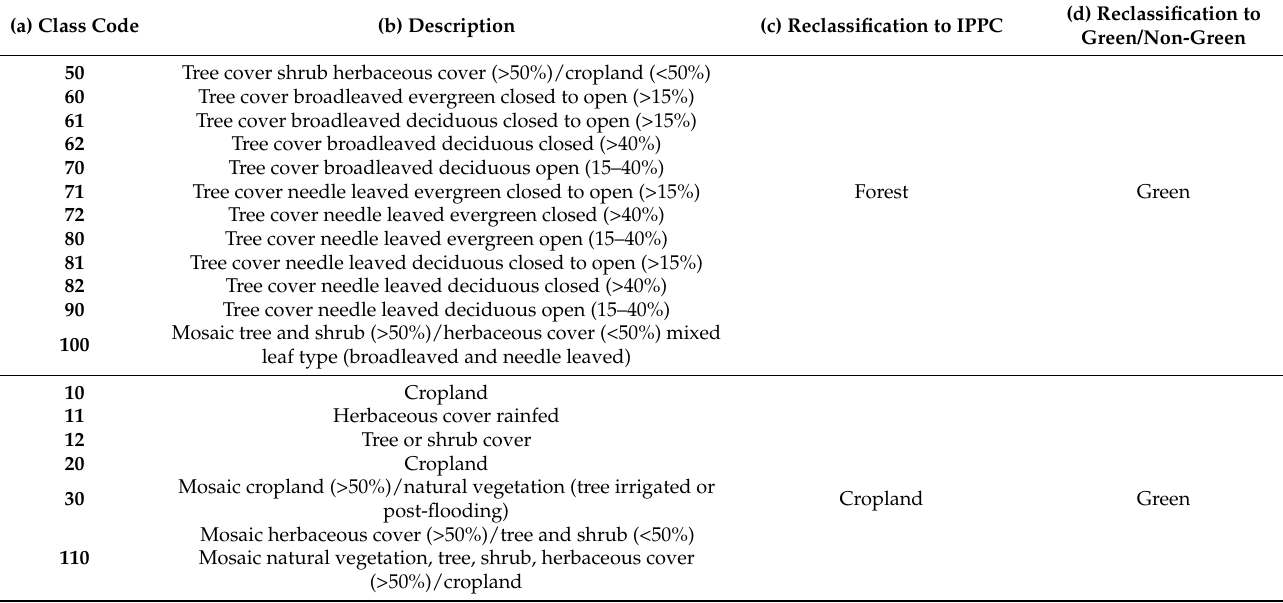
Table 2. ESA CCI-LC land cover codes (a) and (b) description; corresponding IPPC class (c); corresponding green or non-green label